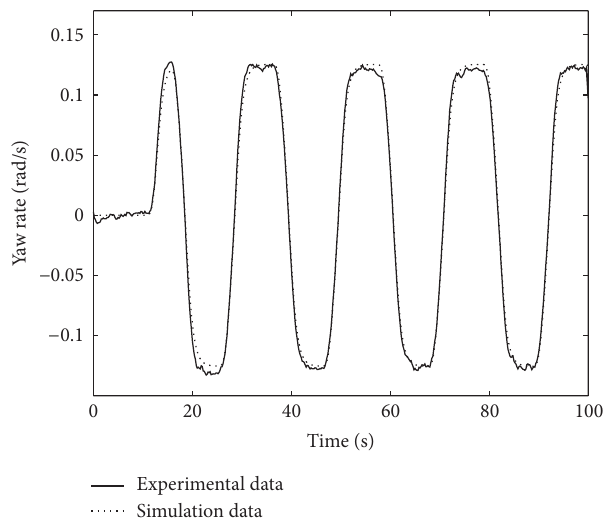
Figure 4: Yaw rate obtained in the zig-zag manoeuvre with the ship (solid line) and in simulation (dotted